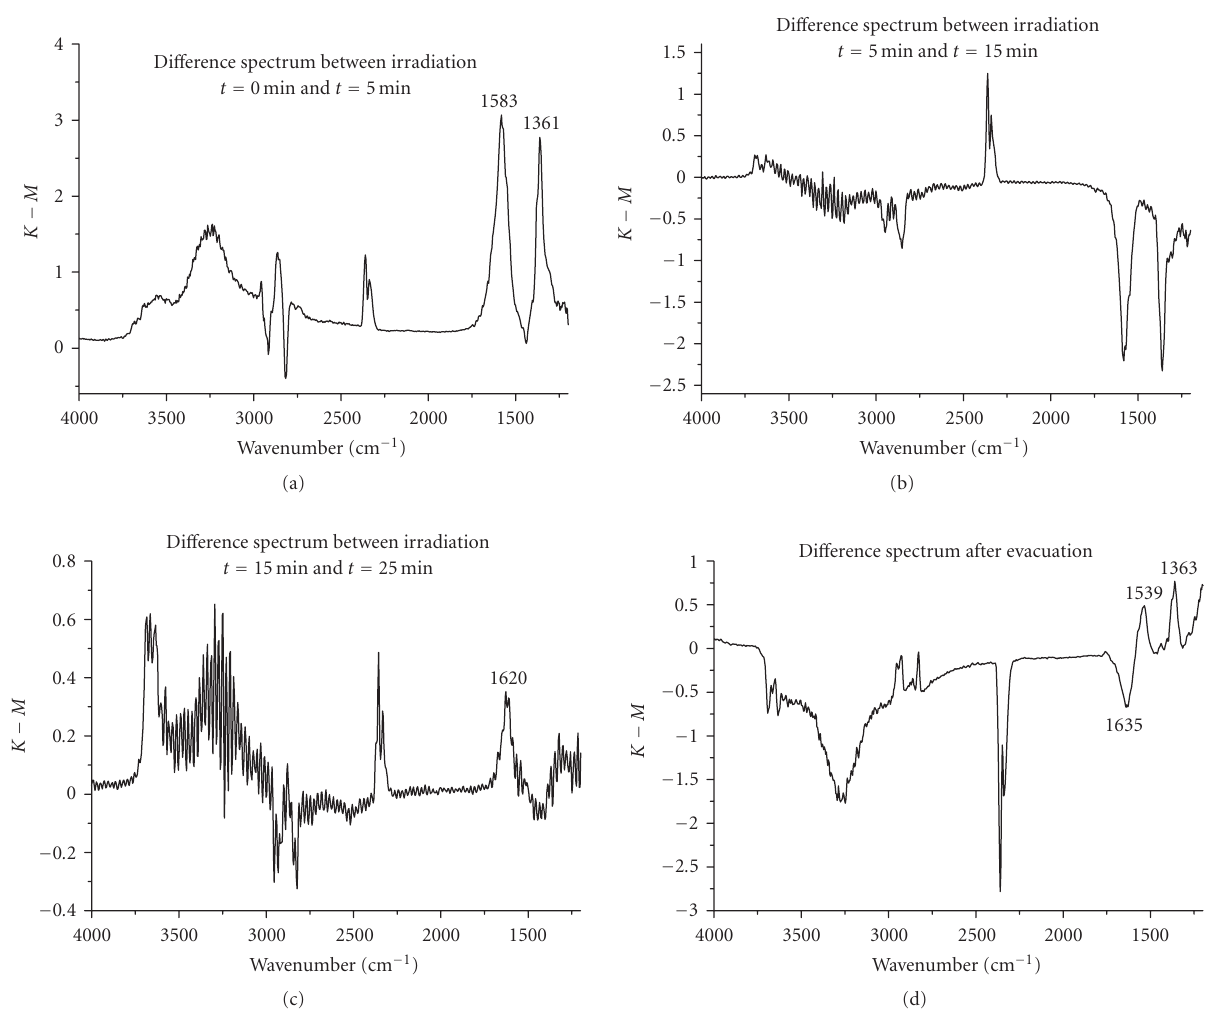
Figure 8: Time series DRIFT di ff erence spectra following course of methanol